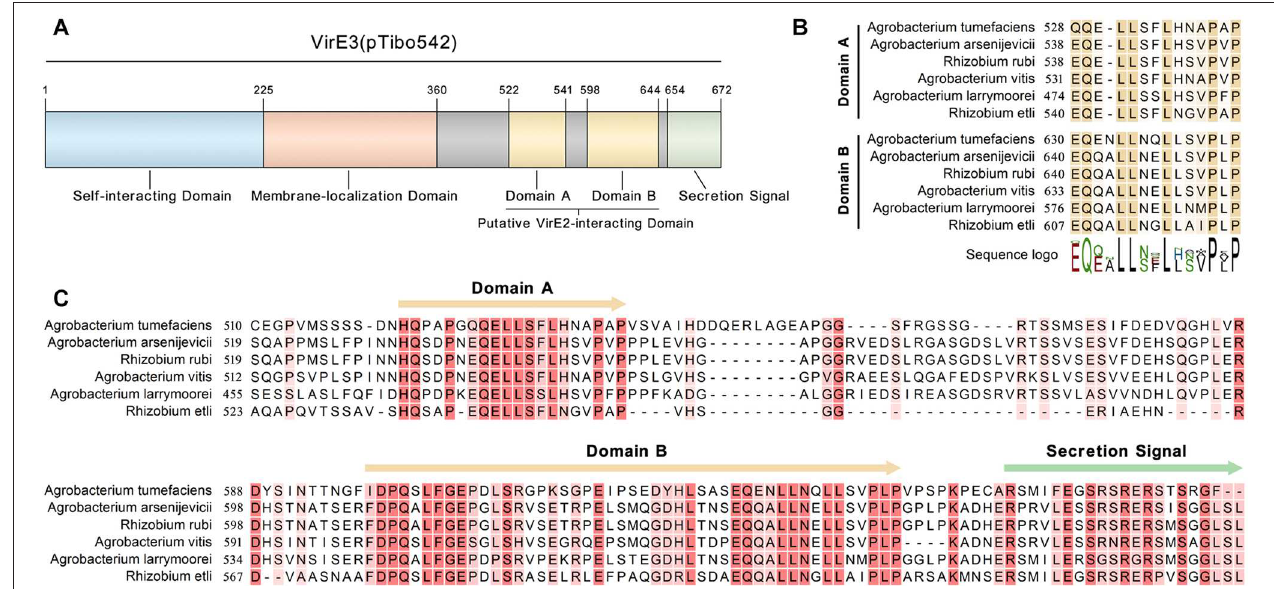
FIGURE 2 | VirE3 contains two putative VirE2-interacting domains at the C-terminus. (A) Schematic representation of the functional domains in VirE3 (pTibo542). The relevant amino acid positions are indicated. (B) Sequence alignment of the C-terminus of A. tumefaciens VirE3 and its homologs from Agrobacterium and rhizobia species. (C) Partial sequence alignment of the two putative VirE2-interacting domains of A. tumefaciens VirE3 and its homologs from Agrobacterium and rhizobia species. Sequence alignments were carried out using the CLC Genomics Workbench